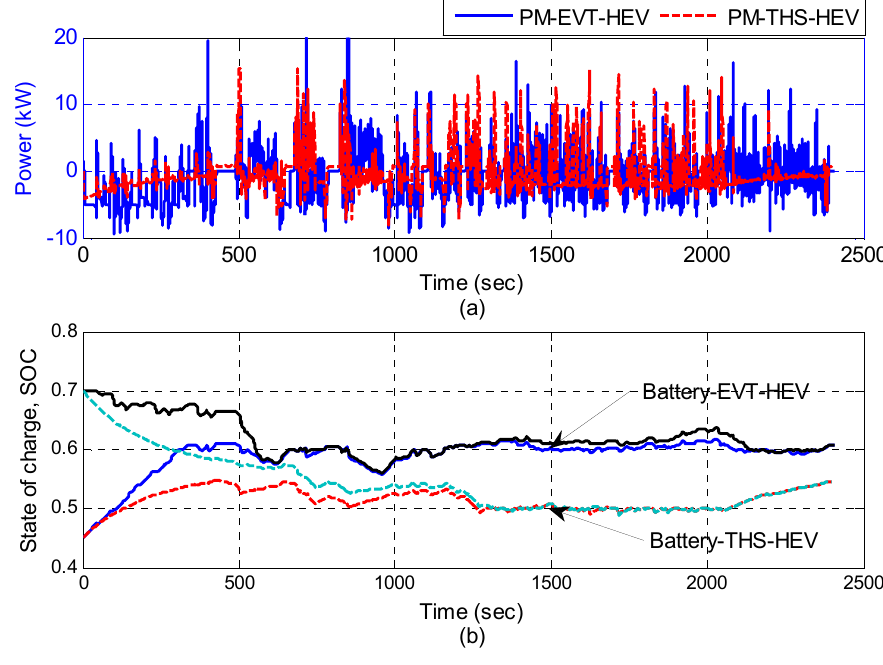
Figure 20. Battery performances of PM-EVT-HEV and Prius THE-HEV: ( a ) Power; and ( b ) SOC of the battery at different initial